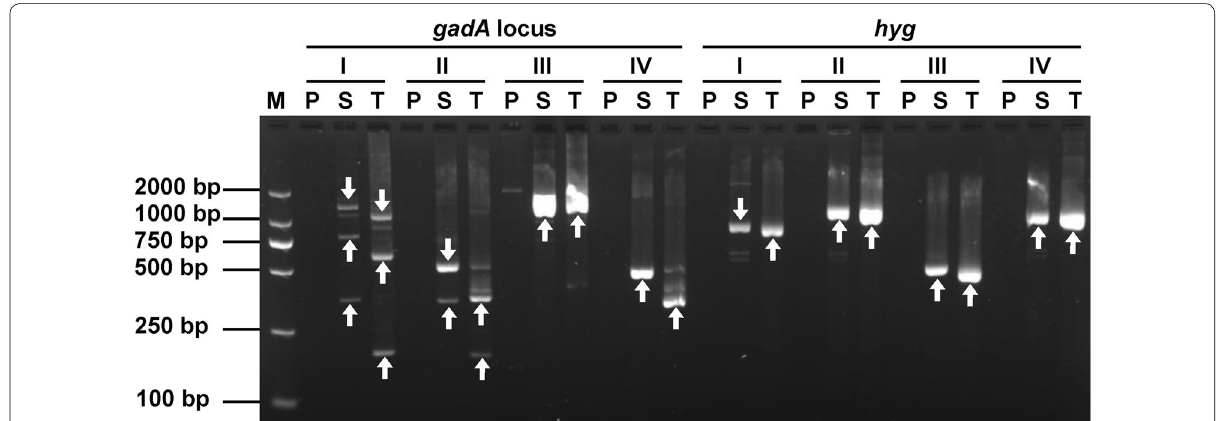
Fig. 2 Genome walking of the gadA locus of Lactobacillus brevis NCL912 and hyg of rice. Each walking experiment contained four sets of PCR reactions that respectively utilized the four SWPOP primer sets, SWPOP1 (I), SWPOP2 (II), SWPOP3 (III) and SWPOP4 (IV), paired with a specific primer set. For each set of PCR reactions, the results of primary PCR (P), secondary PCR (S) and tertiary PCR (T) are presented. White arrows indicate target bands. M: DL2000